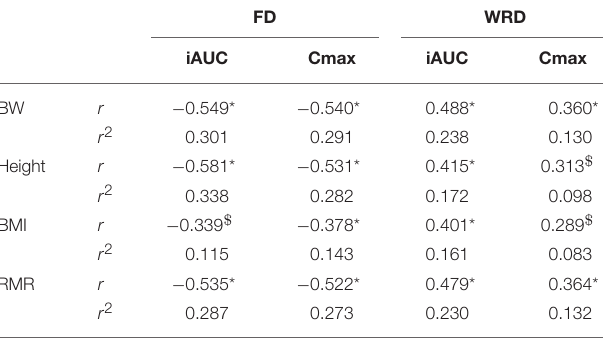
TABLE 3 | Correlations between anthropometrics vs. iAUC and Cmax. FD WRD